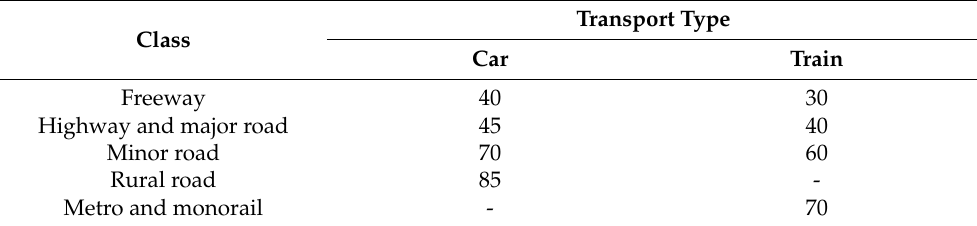
Table 13. Load impact score.